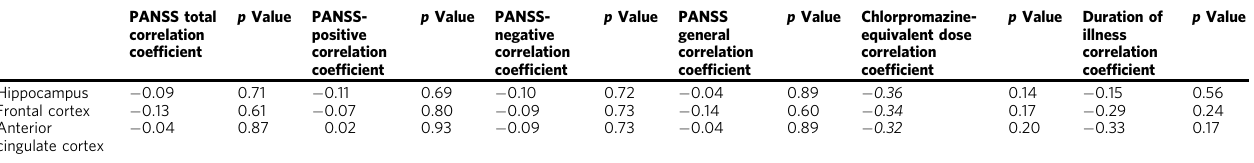
Table 2 Associations between clinical variables and [ 11 C]UCB-J V T .